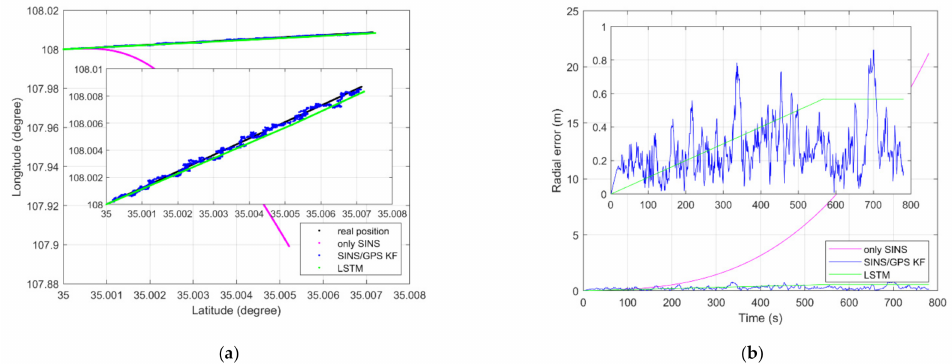
Figure 6. ( a ) Dynamic position estimation of simulation; ( b ) dynamic position radial error of